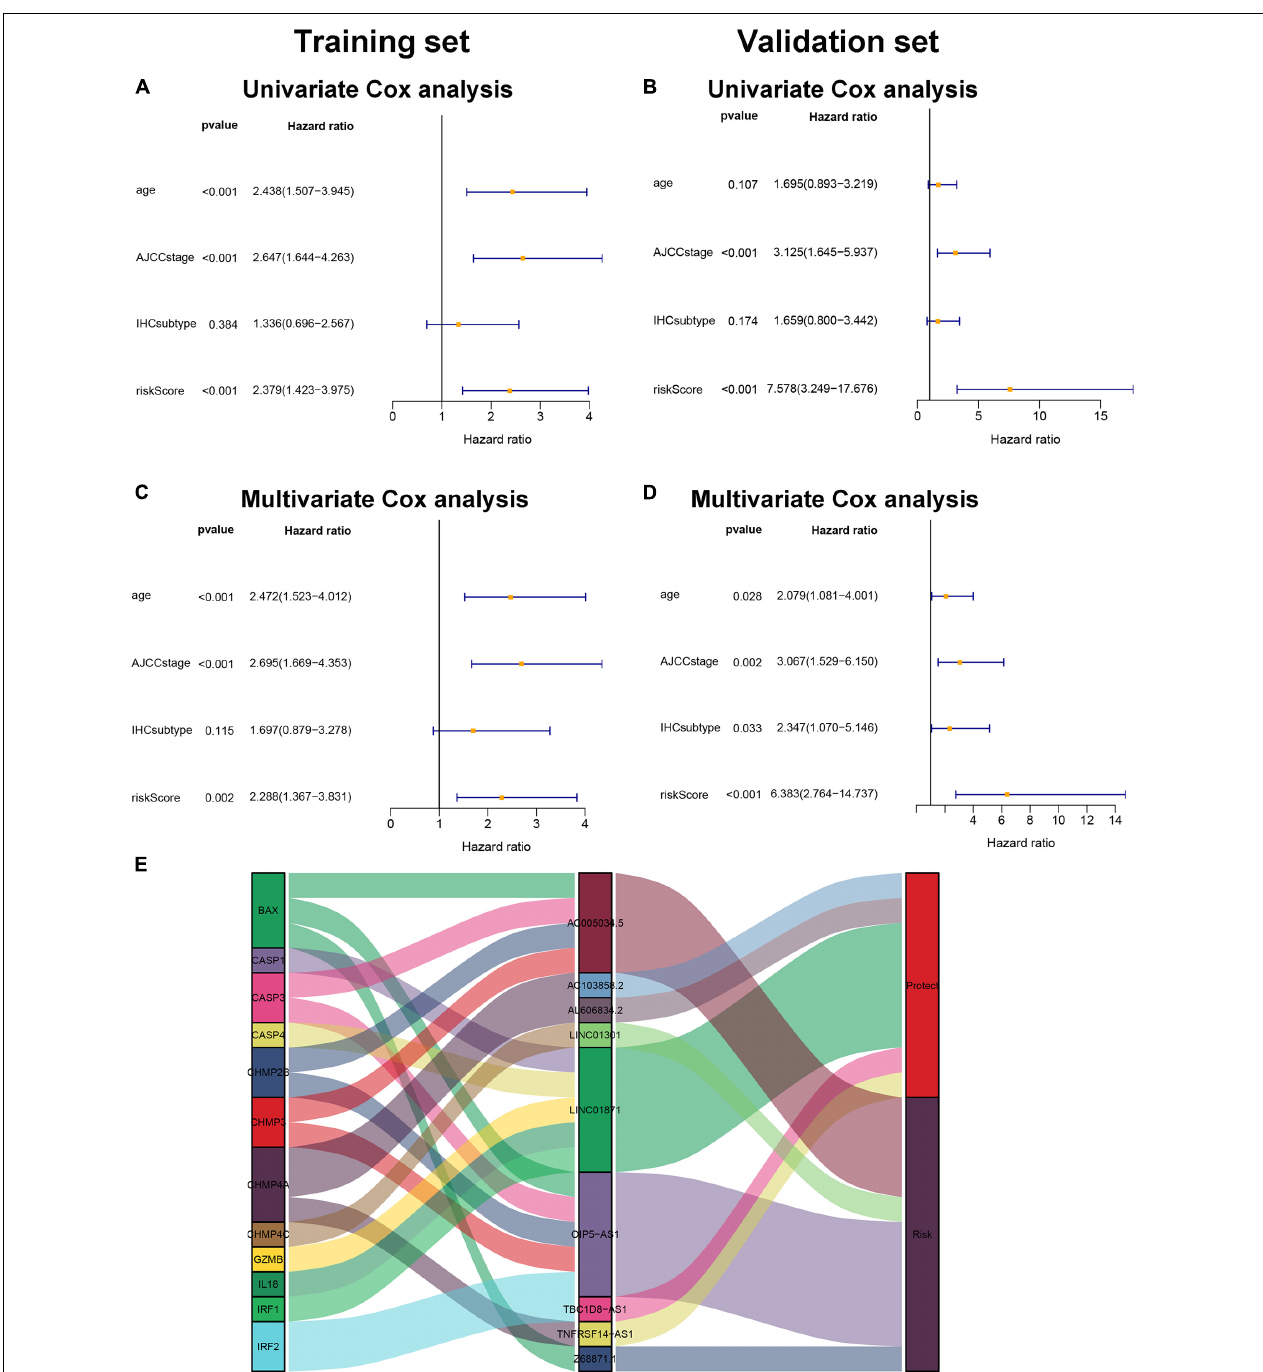
FIGURE 5 | Pyroptosis-associated lncRNA signature is an independent prognostic factor. Univariate Cox regression analysis and multivariate Cox regression analysis of OS are performed in the training set (A,C) and the validation set (B,D) . (E) . LncRNA–mRNA coexpression relationship between the pyroptosis-associated lncRNAs and corresponding genes shown by Sankey